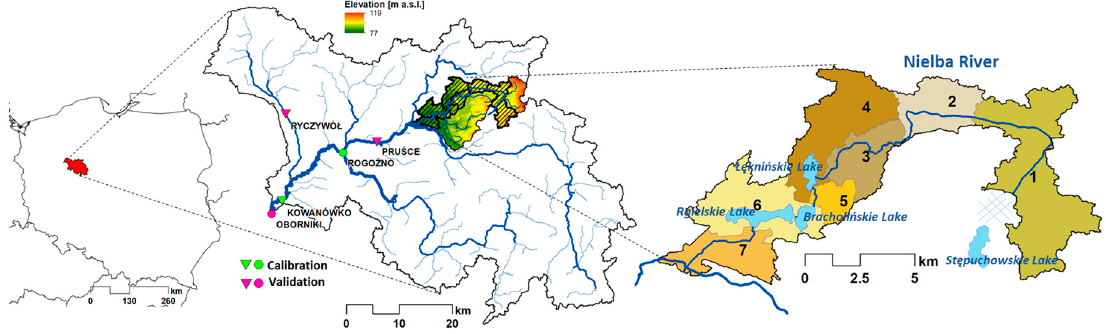
Figure 1. Nielba River location as part of the Wełna catchment, calibration, verification, and validation profiles and its main course sub-basins.